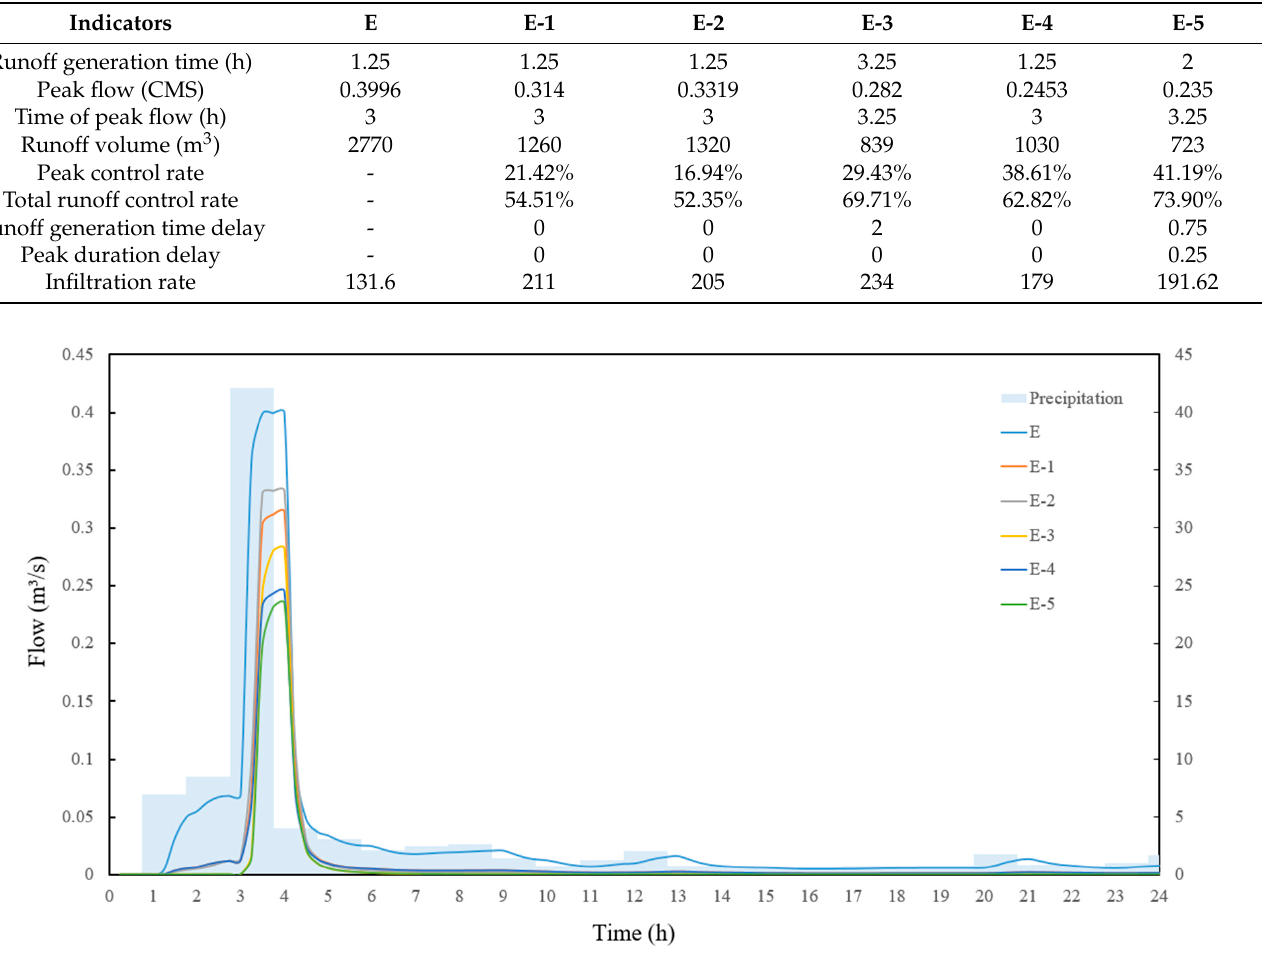
Figure 9. Runoff process in enclosed mode residential areas under rainfall with a return period of 2 years. Table 5. Degree of performance improvement for 5 “what-if” scenarios in enclosed mode compared to the current situation.